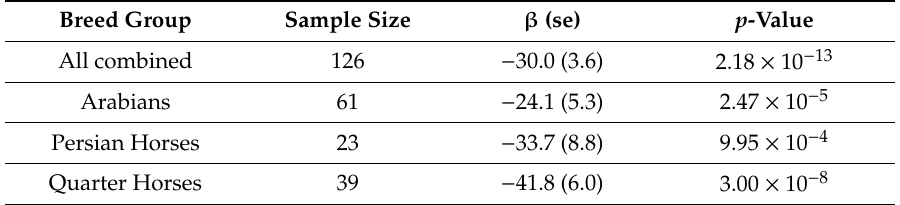
Figure 2. Effect of AX-103117105 on shade of bay. The median bay shade rank for horses in the CC, CT and TT genotype groups was 94.5, 50 and 24, respectively. Upper and lower hinges of boxplots correspond to the first and third quartiles, with the centre line indicating the median and whiskers extending from the hinge to the largest (smallest) value no further than 1.5 x IQR from the hinge; outliers beyond this limit are plotted as unfilled points. Table 1. Association of AX-103117105 with shade of bay rank stratified by breed. Results from a linear regression model fitted with shade of bay rank as the dependent variable and genotype at AX-103117105 (T allele count) as the predictor.